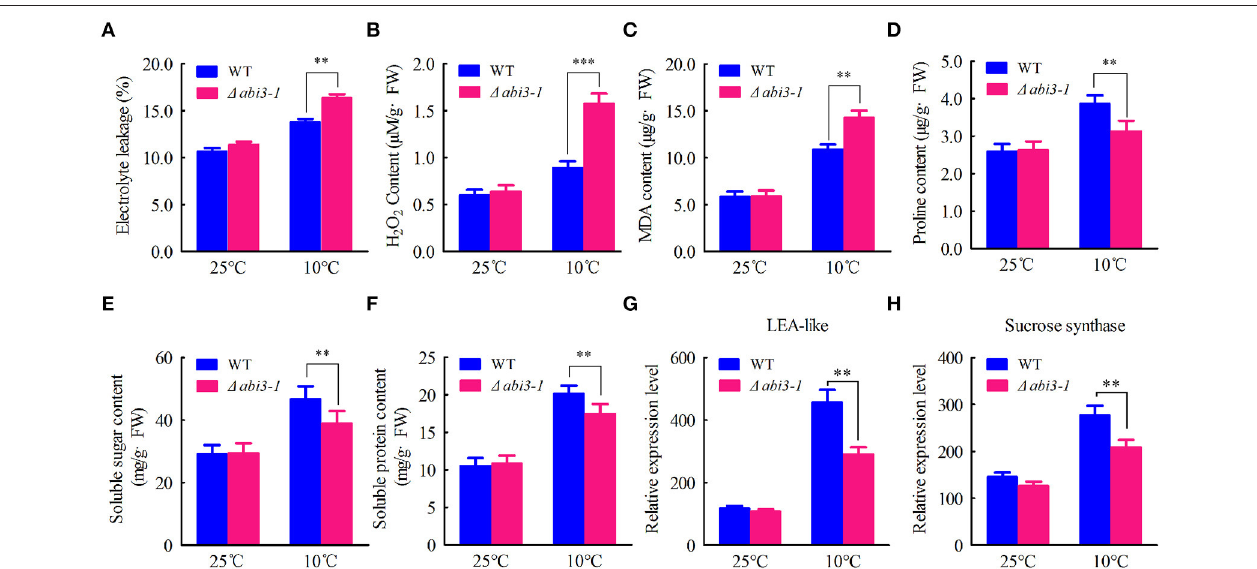
FIGURE 2 | PpABI3 participates in low temperature response of P. patens . (A–C) Analysis of cell injury and oxidative damage. Tissues of WT and ∆ abi3-1 with or without cold acclimation under 10 ◦ C were collected to determine electrolyte leakage (EL) rate (A) , hydrogen peroxide (H 2 O 2 ) content (B) and malonyldialdehyde (MDA) content (C) . (D–F) Analysis the accumulation of cryoprotectants. Tissues of WT and ∆ abi3-1 with or without cold acclimation were collected to estimate proline content (D) , total soluble sugar content (E) and total soluble protein content (F) . Error bars represent SD ( n = 3) and Two-way ANOVA was used to determine the statistical significance (** P < 0.01). (G,H) Quantitative RT-PCR to analyse the expression of a late embryogenesis abundant (LEA)-like protein-coding gene (Pp1s267_21V6.1) and a sucrose synthase-coding gene (Pp1s93_98V6.1). PpACTIN5 (Pp1S381_21V6) was used as internal control. Error bars represent SD ( n = 3) and Two-way ANOVA was used to determine the statistical significance (** P < 0.01; *** P <